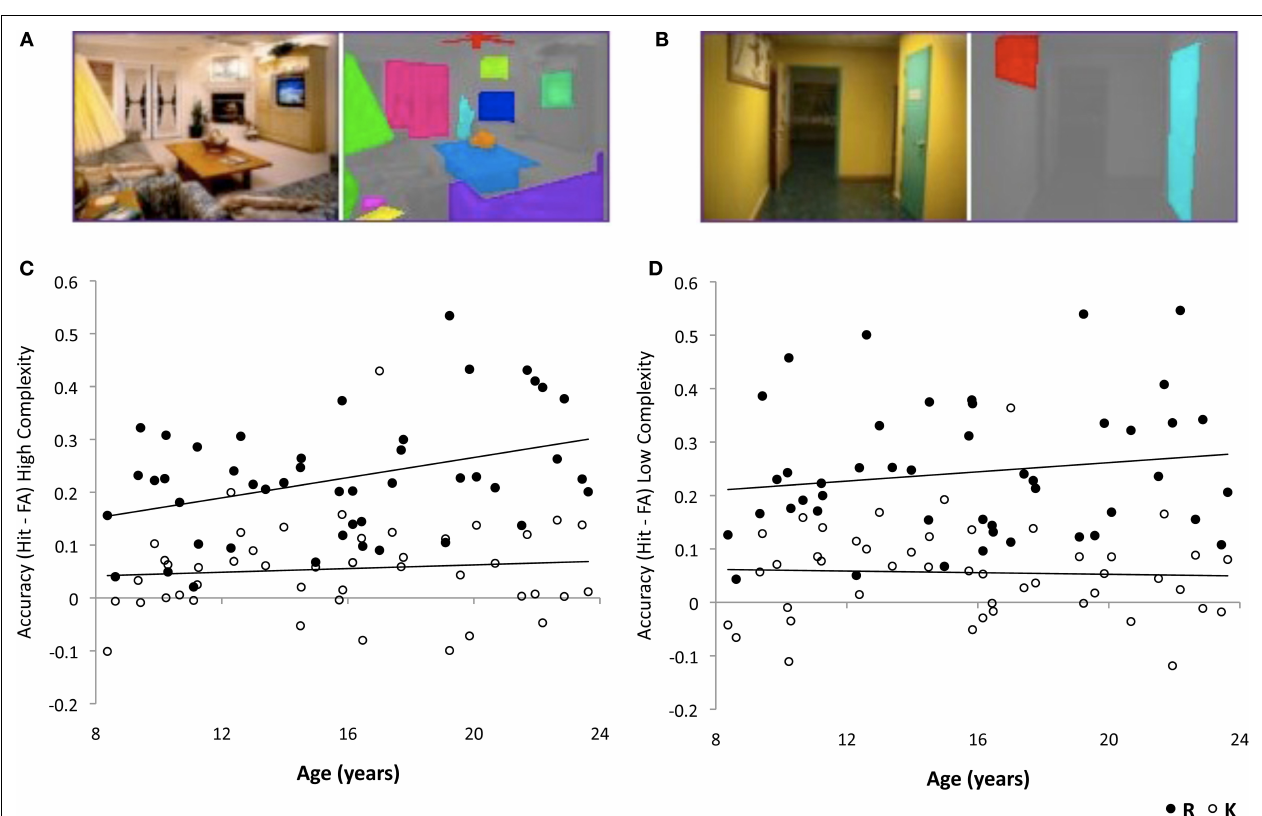
FIGURE 1 | Recollection memory for high-complexity, but not low- complexity, scenes improved signifi cantly with age. Examples of original scenes (left) and items in those scenes identifi ed for complexity calculation (right) for (A) high-complexity scene and (B) low-complexity scene. Adjusted